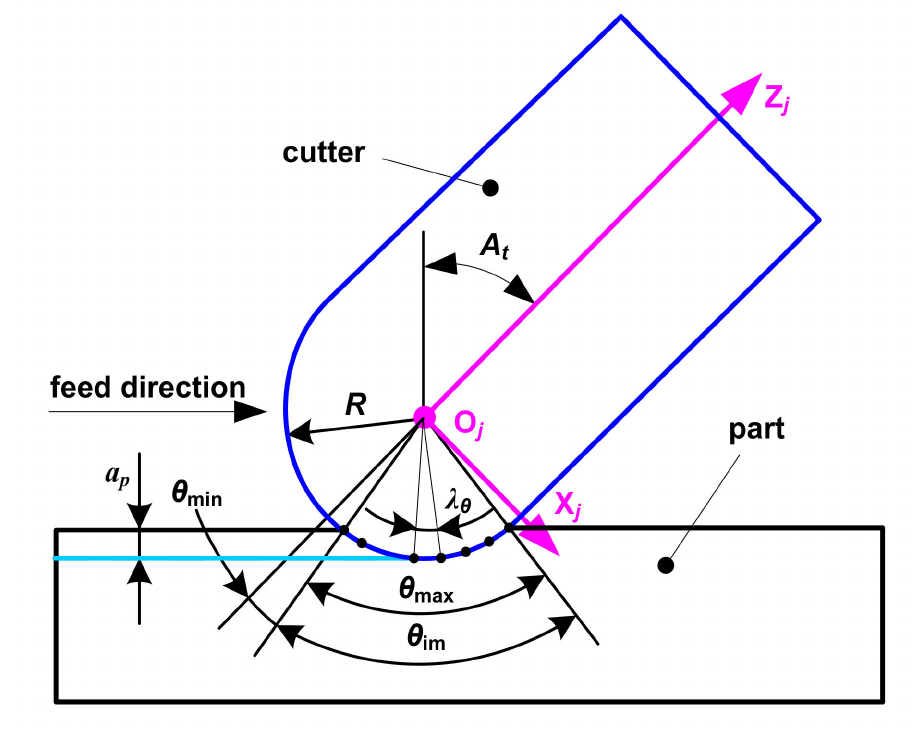
Figure 6. Cutter teeth microelement